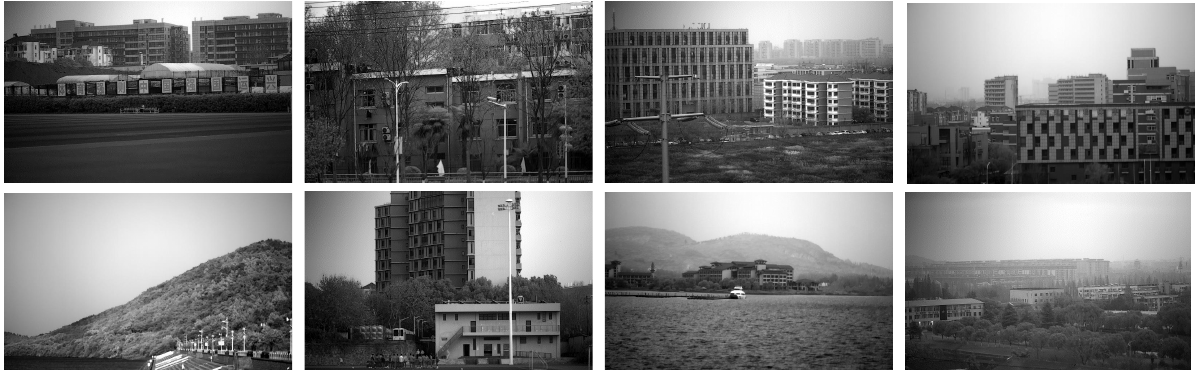
Figure 6. The representative training sets for super resolution.